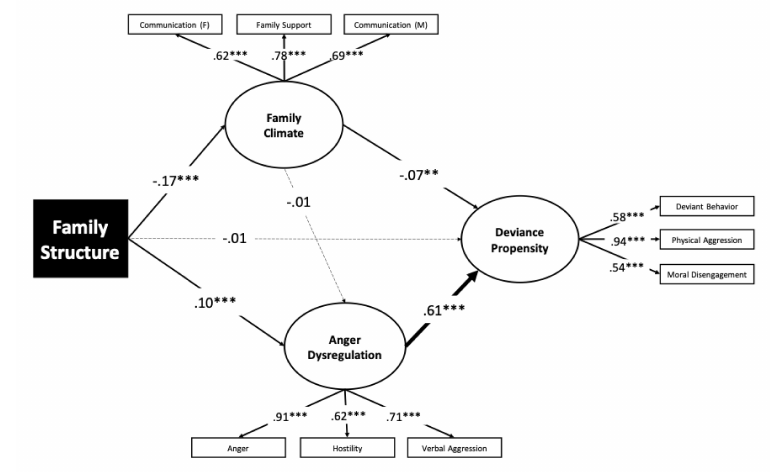
Figure 2. Mediation Analysis. The solid lines represent statistically significant paths ( p < 0.05). The dashed lines represent not significant paths. The thickness of the lines representing structural relationships is proportional to the e ff ect size of the path coe ffi cient. *** p < 0.001, ** p <